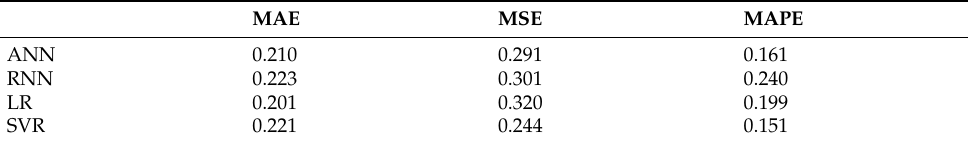
Table 10. Performance of machine learning algorithms (statistics of fit).